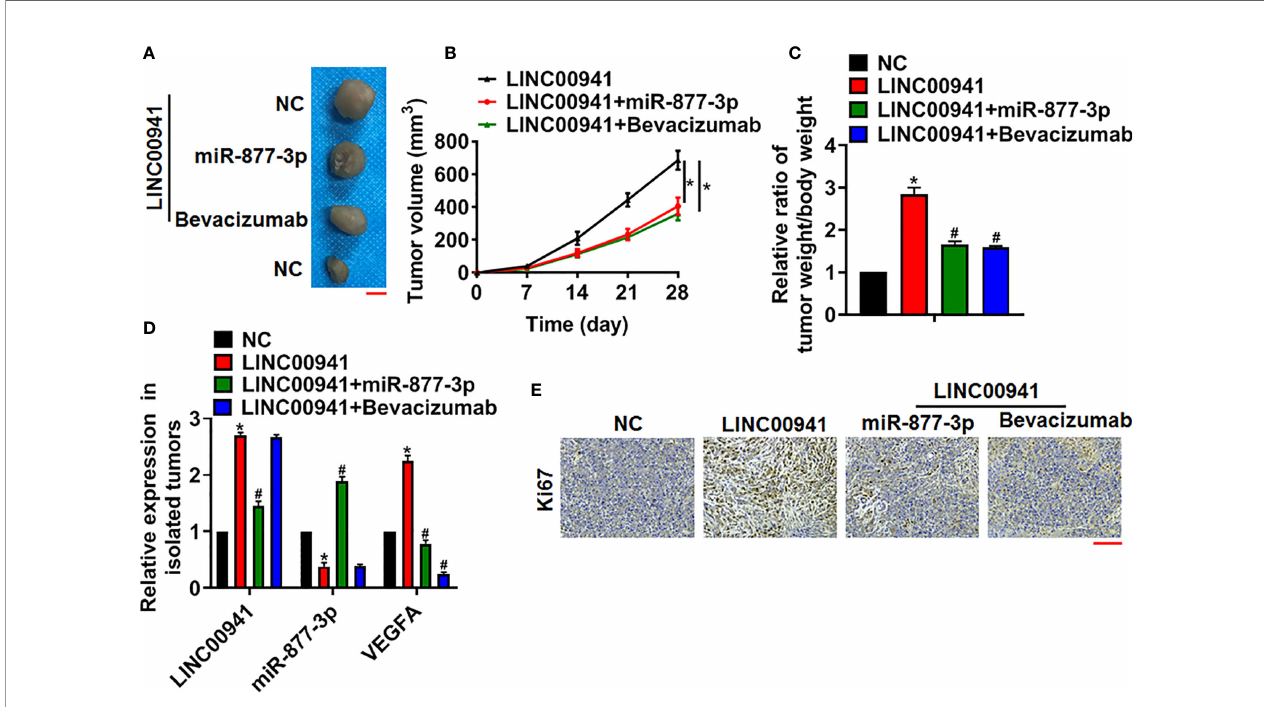
FIGURE 6 | LINC00941 promoted NSCLC growth in vivo via miR-877-3p/VEGFA axis. A549 cells stably expressed LINC00941 were subcutaneously injected into right lower limb of the nude mice. 7 days later, agomiR-877-3p was injected through tail vein, or bevacizumab (10 mg/kg) was intraperitoneally injected. (A) Images of the representative excised tumors at 28 days after injection. (B) Tumor volume was measured every 7 days. (C) The ratio of tumor weigh to body weight was calculated. (D) The mRNA of LINC00941, miR-877-3p and VEGFA in isolated tumors were detected by qRT-PCR. (E) Ki67 staining used to detect the proliferation of isolated tumors. Data are mean ± SD; *P < 0.05 vs NC, # P < 0.05 vs LINC00941. All experiments were repeated three